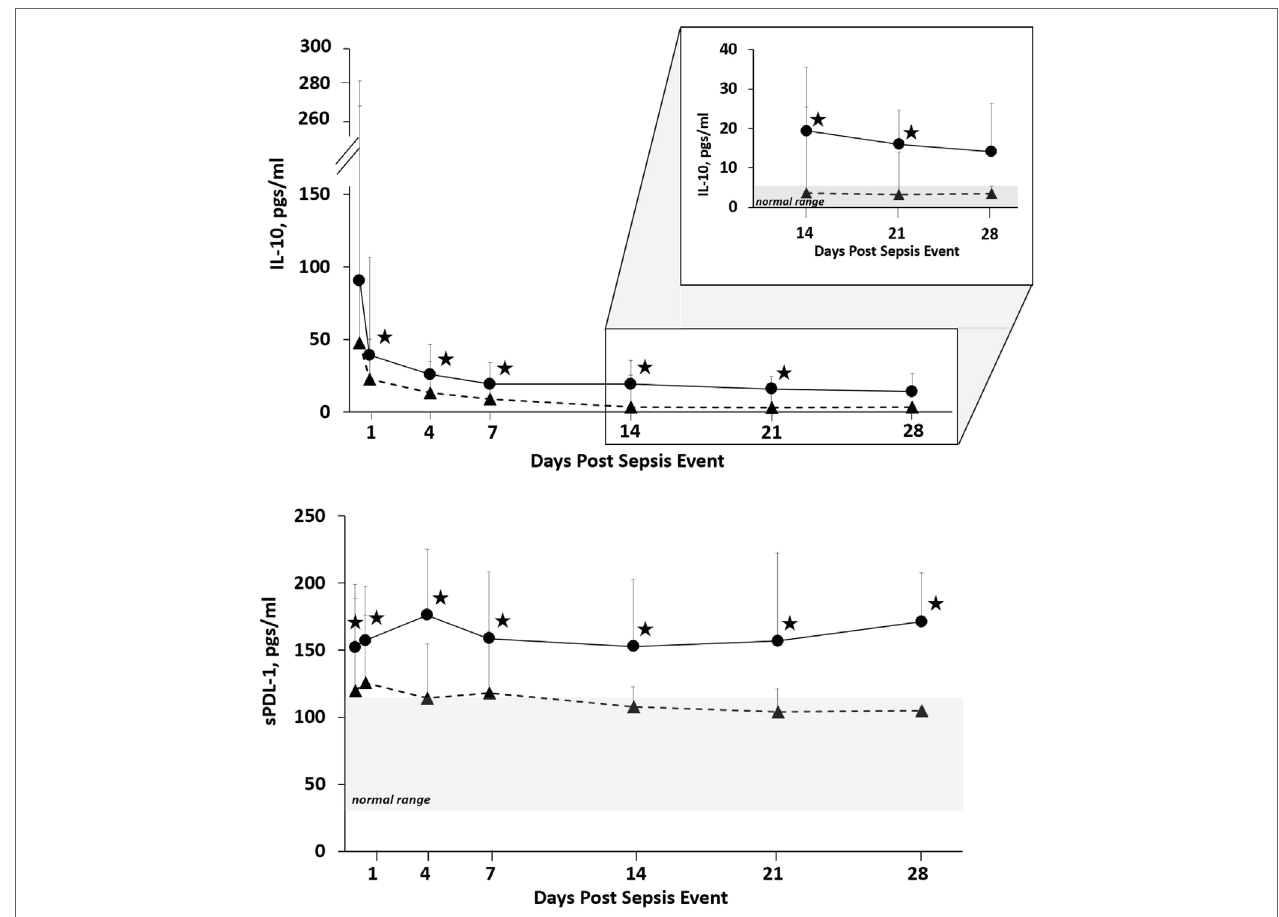
FigURe 4 | Biomarker concentrations in patients with CCI and RAP. Blood samples were collected at 0.5, 1, 4, 7, 14, 21, and 28 days after sepsis onset. Differences in concentrations between CCI (filled circles) and RAP (filled triangles) cohorts at individual time points are identified with an asterisk at a p value less than 0.05 using nonparametric tests. Patients with CCI had evidence of prolonged immunosuppression. Abbreviations: CCI, chronic critical illness; RAP rapid recovery; IL-10, interleukin-10; sPDL-1, soluble programmed death